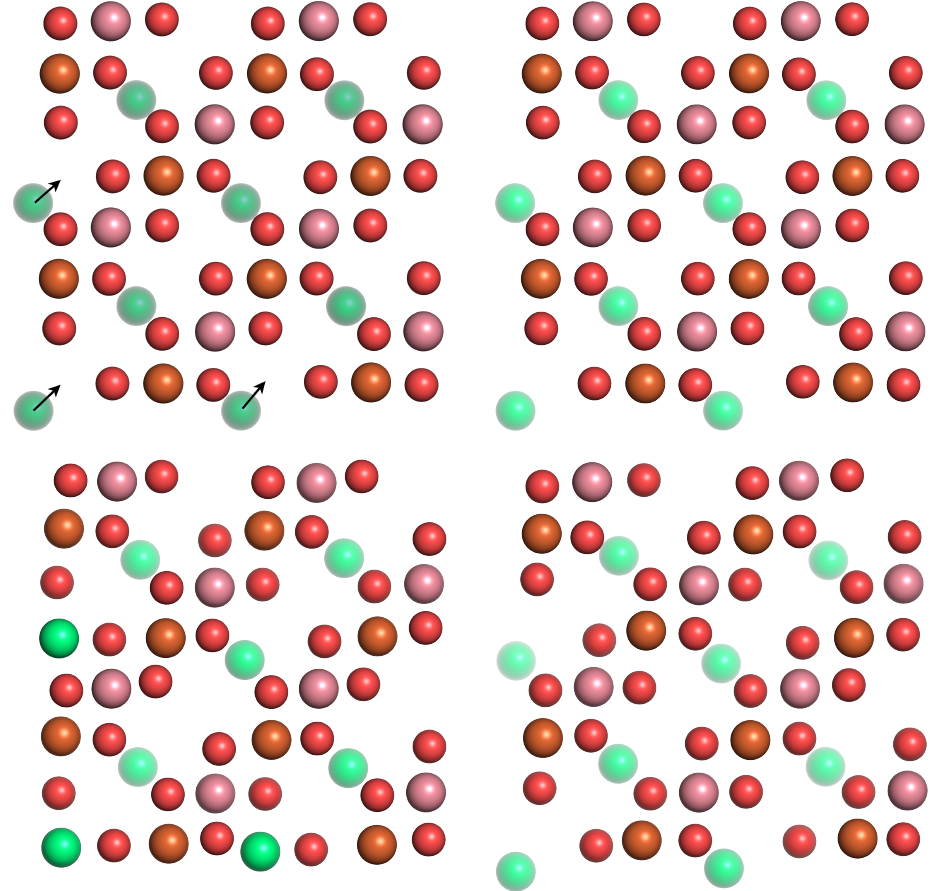
Figure 8. Top views of the initial (top row) and final (after 10 ps; bottom row) surface structures for B-terminated water-free ( left ) and water-covered ( right ) CoFe 2 O 4 (001) surfaces, with atom coloring Fe 3+ (oct): brown, Fe 3+ (tet): green, Co 2+ : purple, O: red as in Figure 2. Fe 3+ (tet) ions below the top surface layers are partially grayed out. The arrows indicate the reconstruction of the Fe 3+